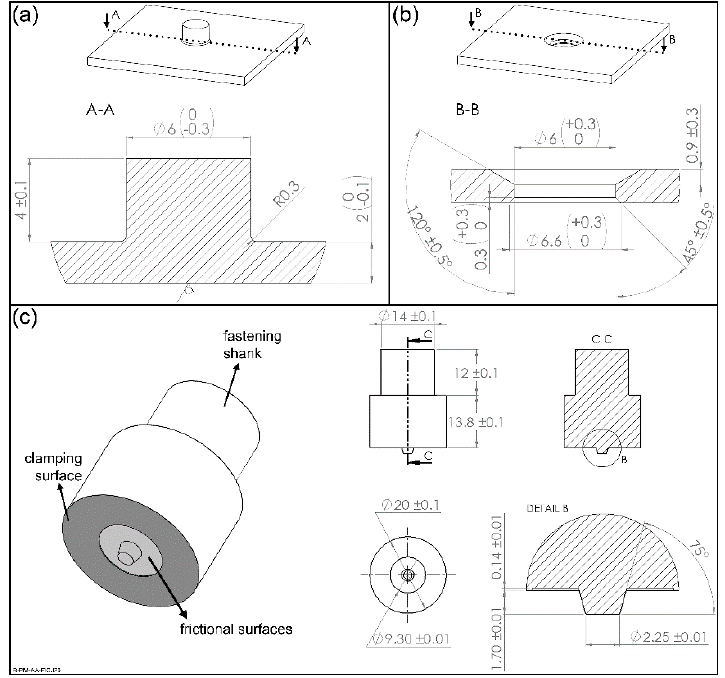
Figure 3. Base materials used. ( a ) Polyetherimide (PEI) part. ( b ) Aluminum 6082-T6 part; ( c ) F-ICJ tool made of stainless steel 316L.